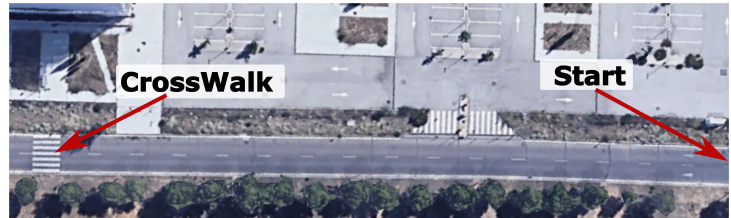
Figure 19. Section of the road of UAH map (Figure 12a) where the crosswalk with pedestrian scenario takes